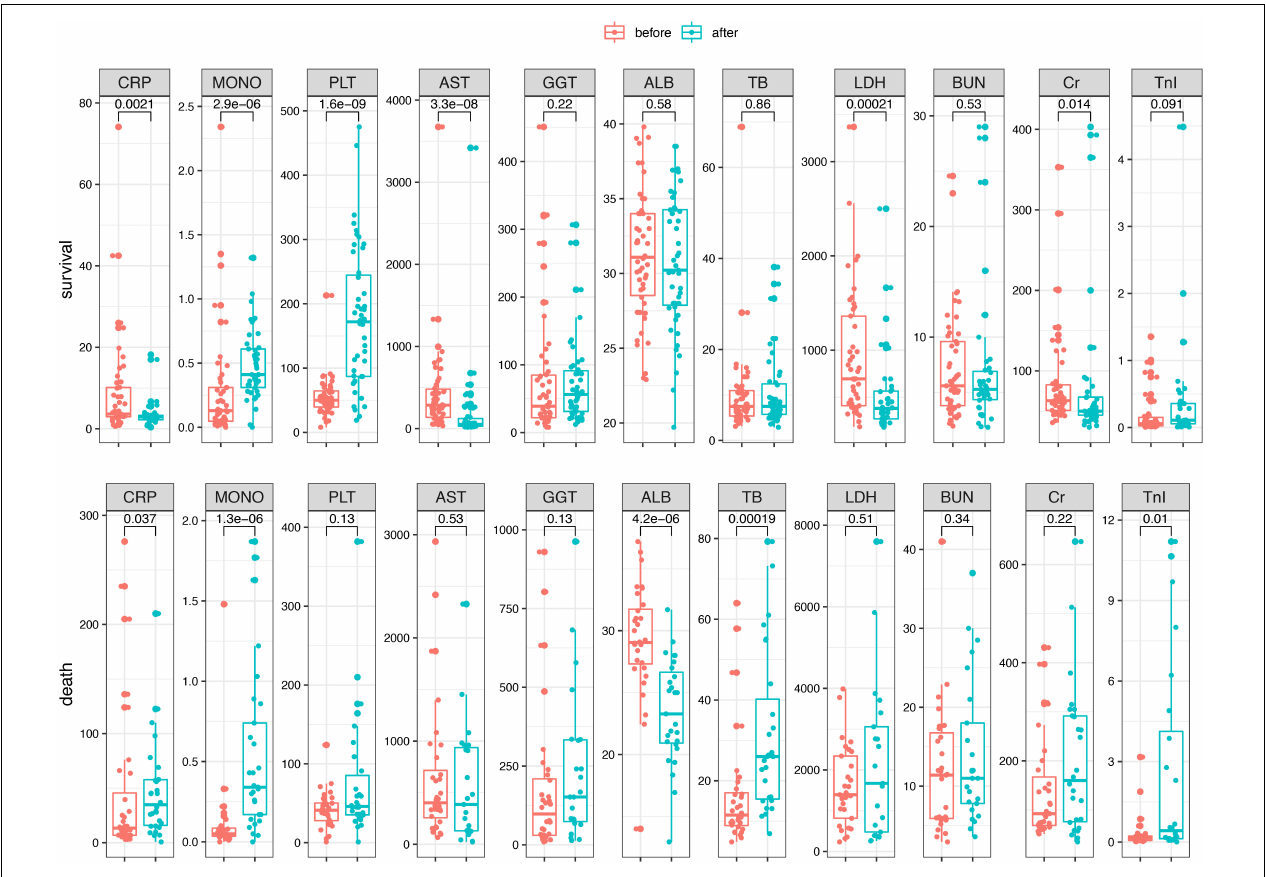
FIGURE 3 | The dynamic changes of the differential biomarkers before and after treatments in the SFTS